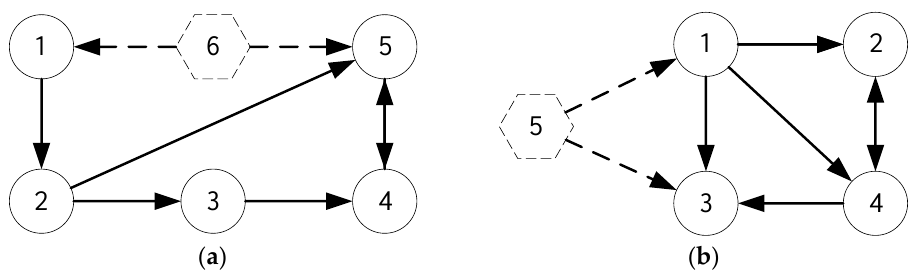
Figure 2. The directed communication topology. ( a ) The directed communication topology of leader and five followers in example 1 and example 2; ( b ) The directed communication topology of one leader and four followers in example 3.